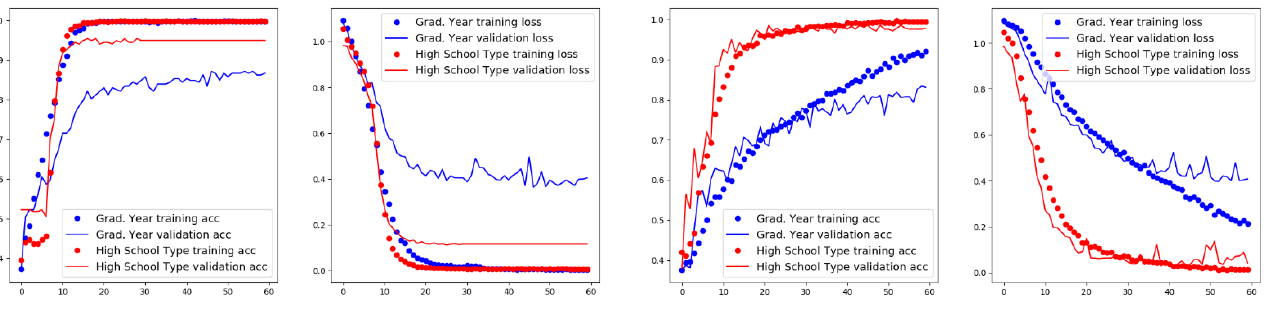
Fig. 6. Learning curve of image classification model Table 5. Image classification performance on test dataset